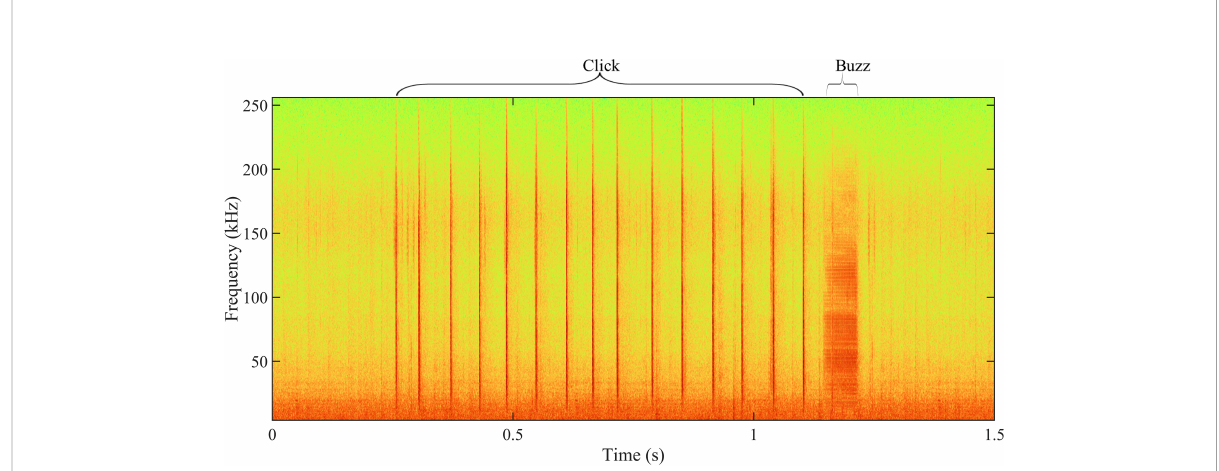
FIGURE 4 Example of sequential appearance in spectrograms showing representative click and buzz signal produced by Indo-Paci fi c humpback dolphins. Spectrogram settings: high pass fi lter, fi lter-out noise under 4 kHz, Hamming window, FFT size = 512 points, frequency overlap =